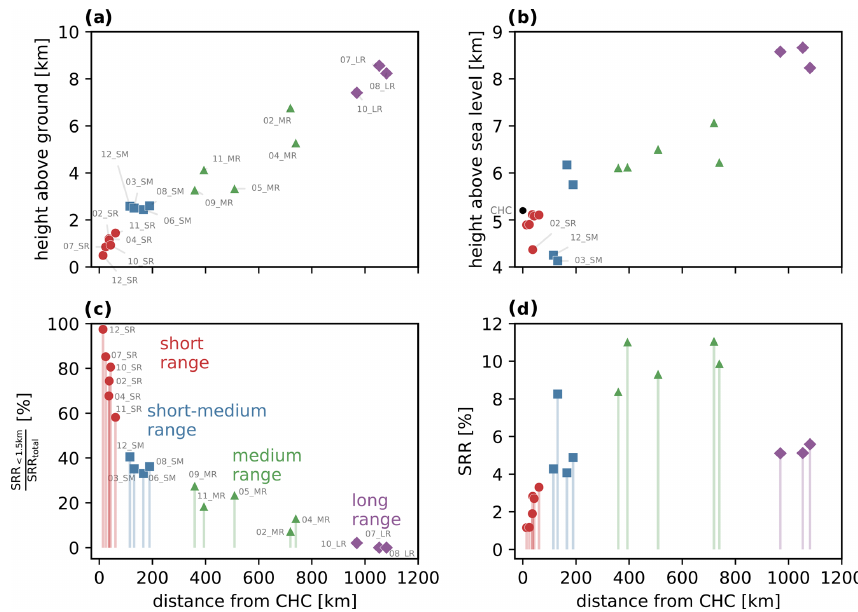
Figure 10. Cluster-median properties for each cluster. The horizontal axis for all panels represents the radial distance from CHC. Panel (a) shows the median height above ground level of each cluster, while (b) shows the height above sea level. Panel (c) shows the median ratio between the SRR values that are below 1.5km above ground level and the total SRR value for each cluster. Panel (d) shows the median SRR percentage for each